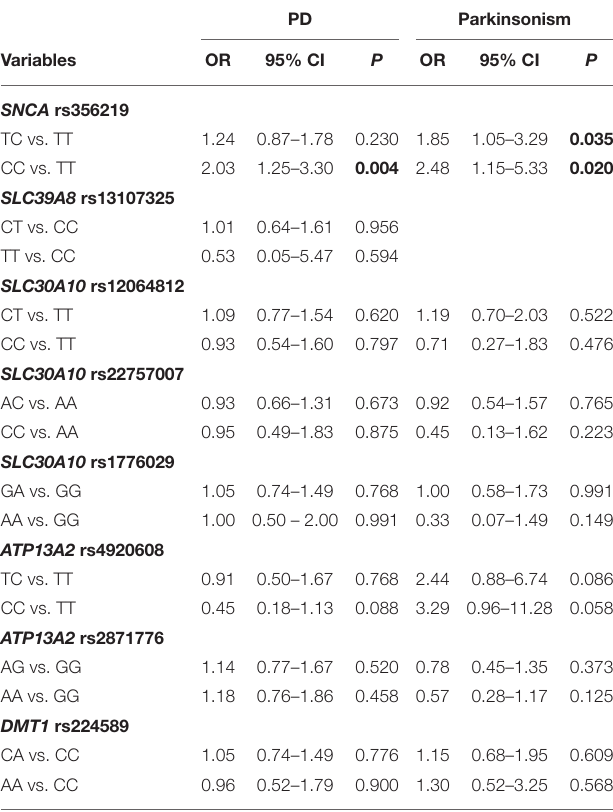
Adjusted regression odds ratios, 95% CI, and their p-values are shown. For SLC39A8 rs13107325 only the association with PD is shown since carriers for the TT genotype were too few for Parkinsonism. p-values below 0.05 are shown in